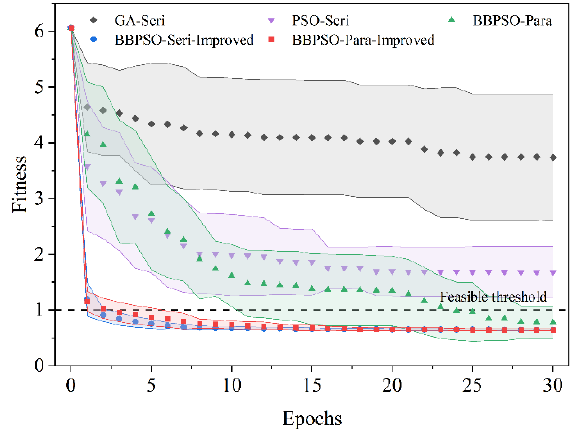
Figure 9. Fitness curves of five algorithms. Table 1 details the performance of five algorithms, including the average calculation time, the average convergence epochs (nonconvergence is calculated according to the maximum epoch number of 300), and average convergence rate. When the fitness is less than 0.65, the method converges to the optimal global solution. The improved BBPSO algorithm exhibited a stronger global optimization ability and converged on the optimal global solution quickly and efficiently. Thus, parallel computing considerably reduces the solving time and efficiency. The larger the scale of the ventilation system is, the higher